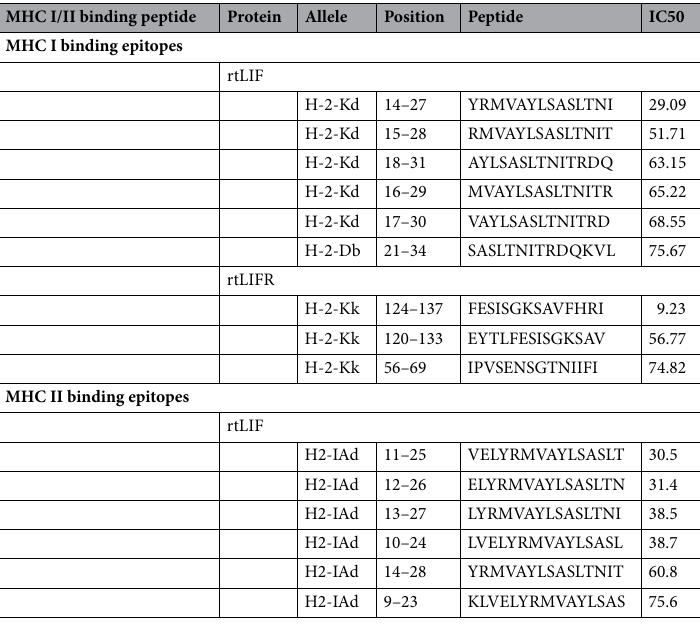
Table 1. Prediction of T cell epitopes by IEDB server.